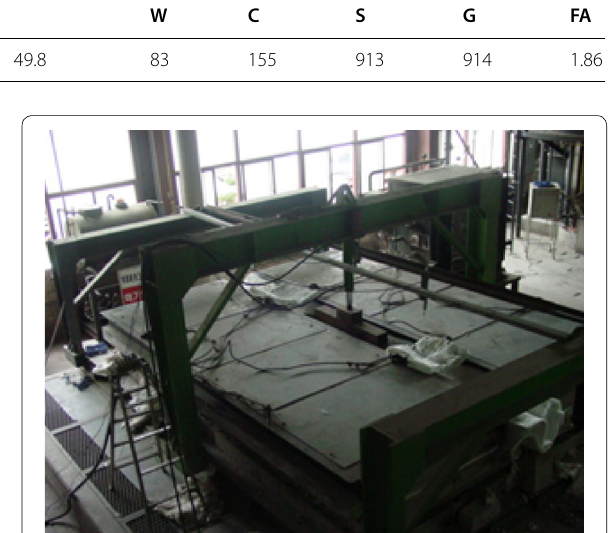
Fig. 2 The horizontal heating furnace for fire